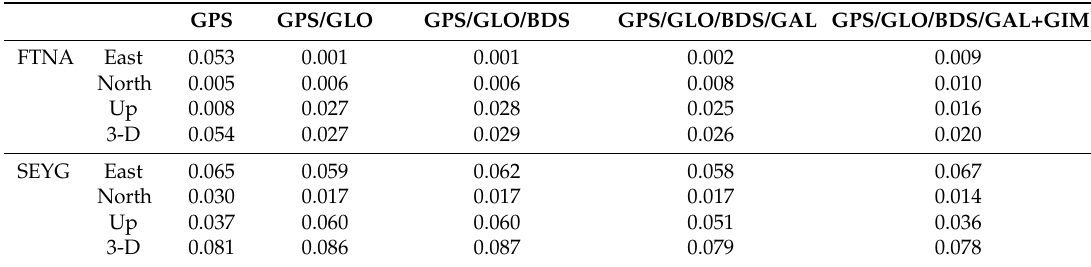
Table 1. RMS statistics of single-frequency PPP coordinate deviations for five different processing scenarios